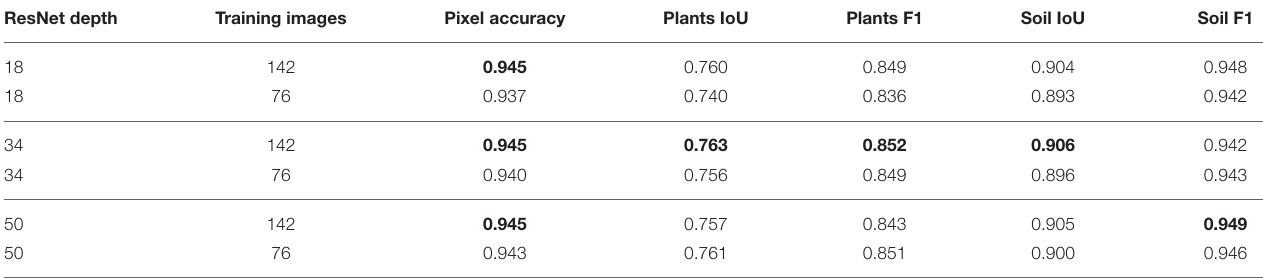
TABLE 3 | Influence of different ResNet encoder depths and dataset sizes. ResNet depth